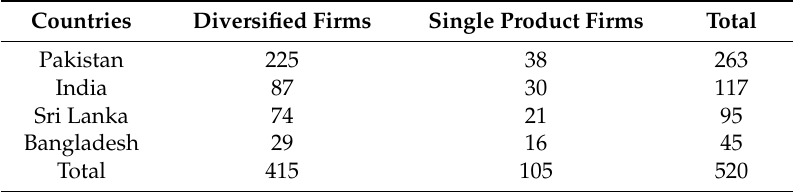
Table 1. Categories of the